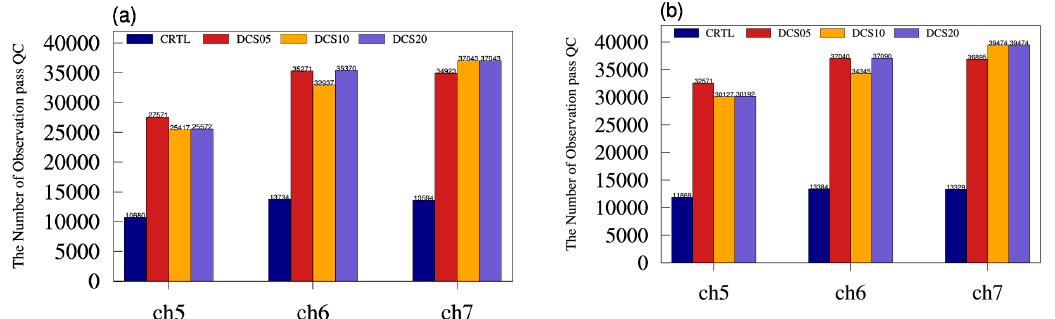
Figure 7. The quantity of observations of MWTS-2 channels 5–7 after applying dynamic channel selection (DCS), for four experiments conducted at (a) 0600 UTC and (b) 1200 UTC on December, 10 2018. The dark blue column is the quantity of CTRL observations without application of DCS and the other three columns are the quantities of observations with use of DCS.